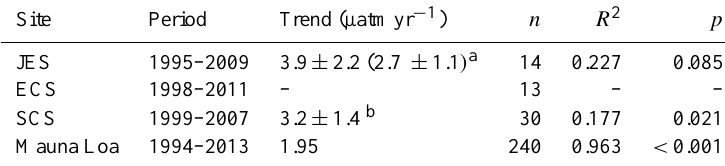
Table 2. Trends of observed p CO 2 in surface waters of the marginal seas. Also listed is that in the air from Mauna Loa for comparison.